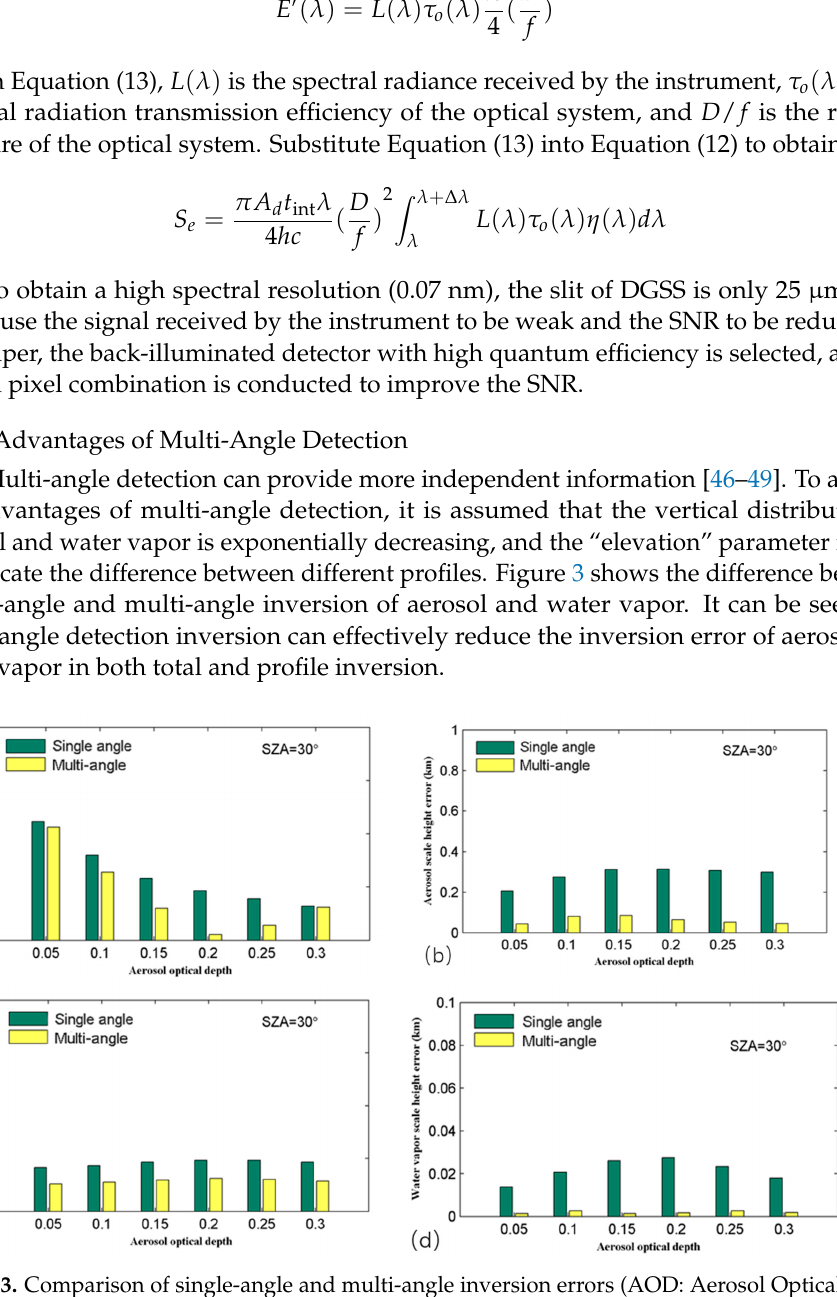
Figure 3. Comparison of single ‐ angle and multi ‐ angle inversion errors (AOD: Aerosol Optical Depth, PWV: Precipitable Water Vapor, SZA: Solar Zenith Angle): ( a ) Aerosol optical depth error; ( b ) Aerosol scale height error; ( c ) Retrieved PWV error; ( d ) Water vapor scale height error.